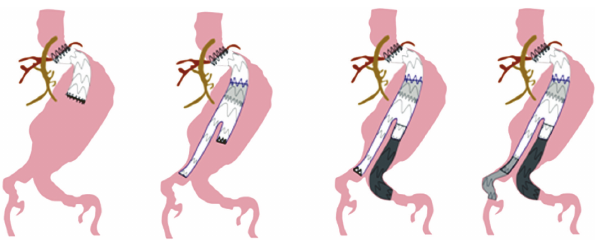
Figure 3: The sequence of the graft insertion.